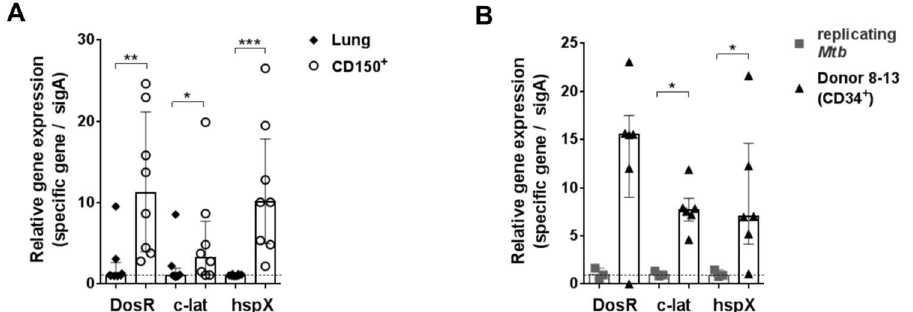
Fig 5. Murine and human pHSCs are infected with Mtb expressingdormancy genes. (A) Expression analyseson RNA isolated from Mtb -infectedmouse lung cells and purifiedLT-pHSCs (n = 8). (B) Expression analyseson RNA isolated from Lin – CD34 + pHSCs from IGRA + donors (n = 6) and Mtb -infectedhuman monocytic leukemiacell line 96 h p.i. (n = 3). Expression analyseswere done by real-time TaqMan PCR for SigA , DosR , c-lat and hspX . SigA was used as reference for Mtb . Real-timeTaqMan PCRs were performed in 3 independent runs in technicaltriplicates. Data are shown as median + interquartile. * P < 0.05, ** P < 0.005, *** P < 0.005 by Mann-Whitney